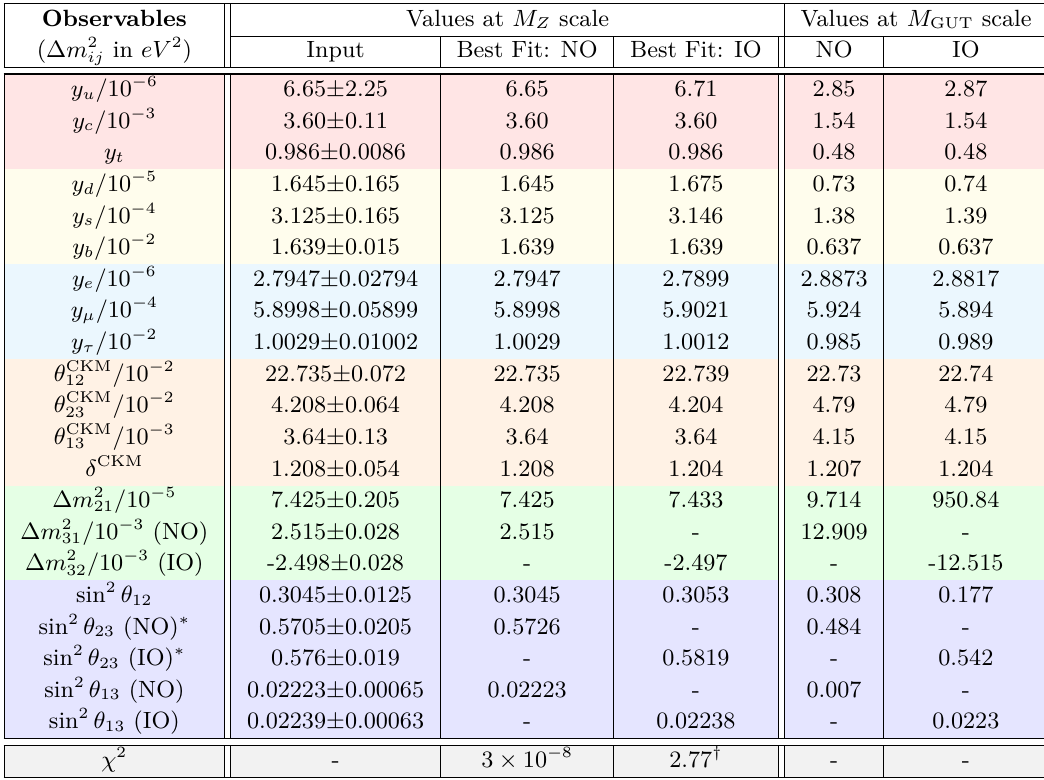
Table 1 . Best fit values of the observables without restricting the U(1) B − L breaking scale. ∗ Note that experimental measurements of θ 23 have two local minimum, one corresponds to θ 23 < 45 ◦ and the other θ 23 > 45 ◦ , see ref. [52]. The Yukawa couplings, y f , at the GUT scale are defined below eq. (2.14). † It is important to point out that for the inverted neutrino mass ordering, a total